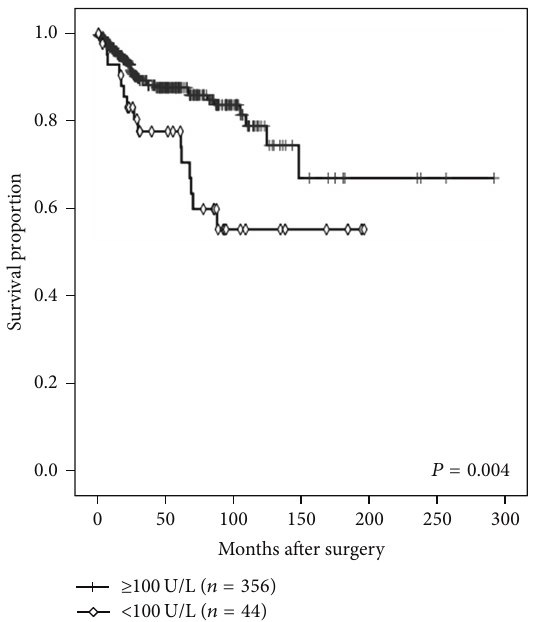
Figure 2: Kaplan-Meier estimate of overall survival (OS) according to serum butyrylcholinesterase (BChE) levels. The 3-year OS rate was 89.3% in patients with preoperative BChE levels of ≥ 100U/L and 77.7% in those with preoperative BChE levels of < 100U/L ( 𝑃 = 0.004